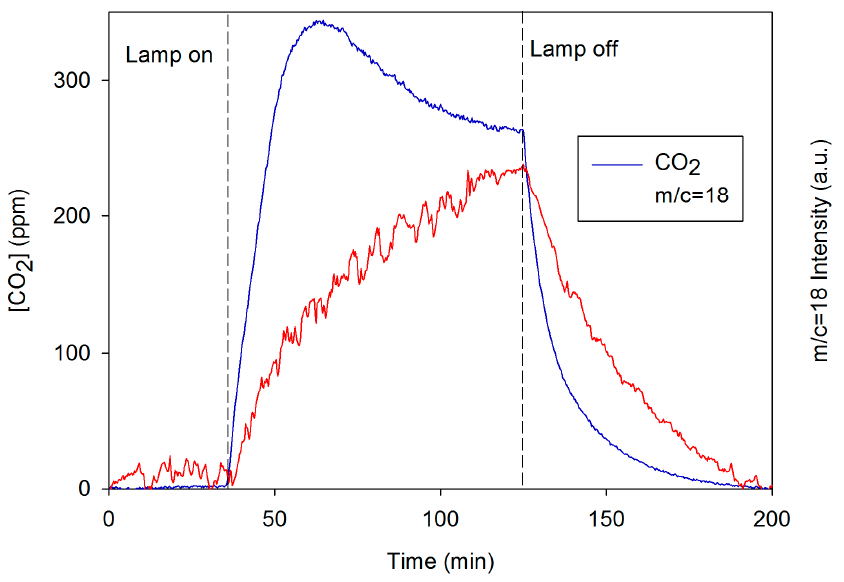
Figure 11. Evolution of CO 2 concentration and m / c = 18 signal (water) during the mass spectroscopy experiment.